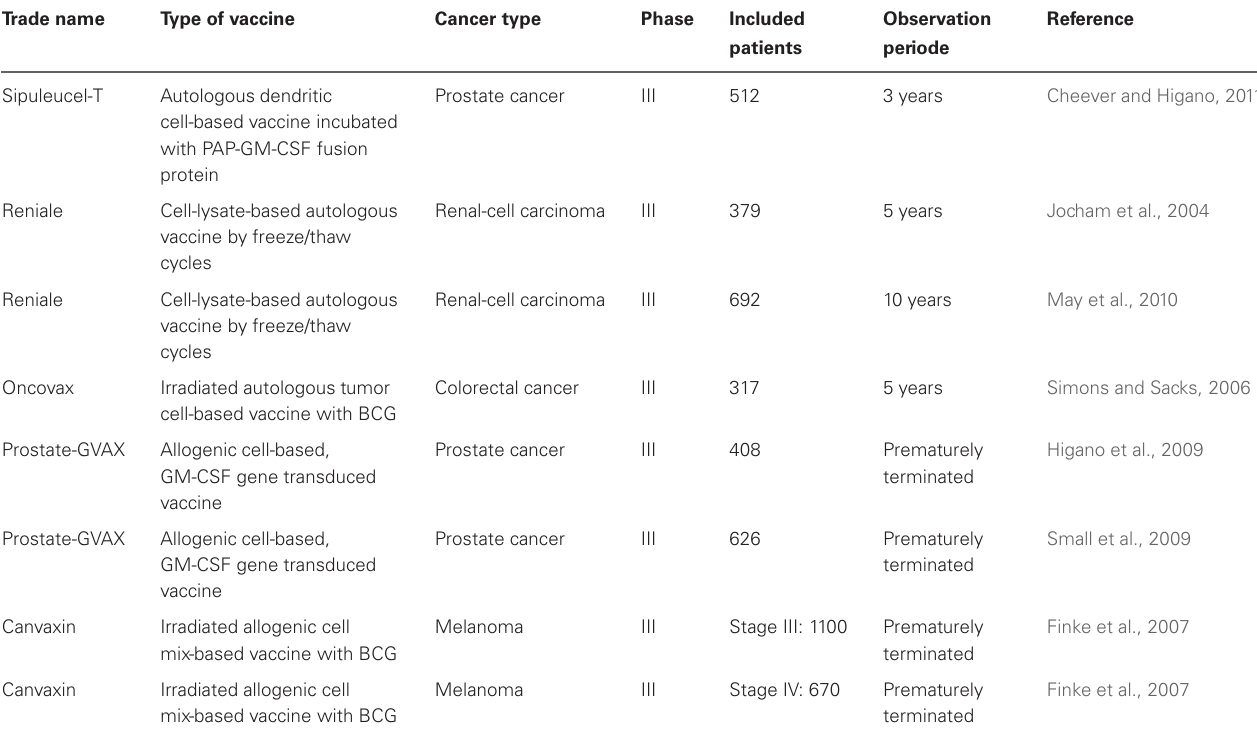
Table 1 | Overview of whole tumor cell-based vaccines that have been tested in Phase III